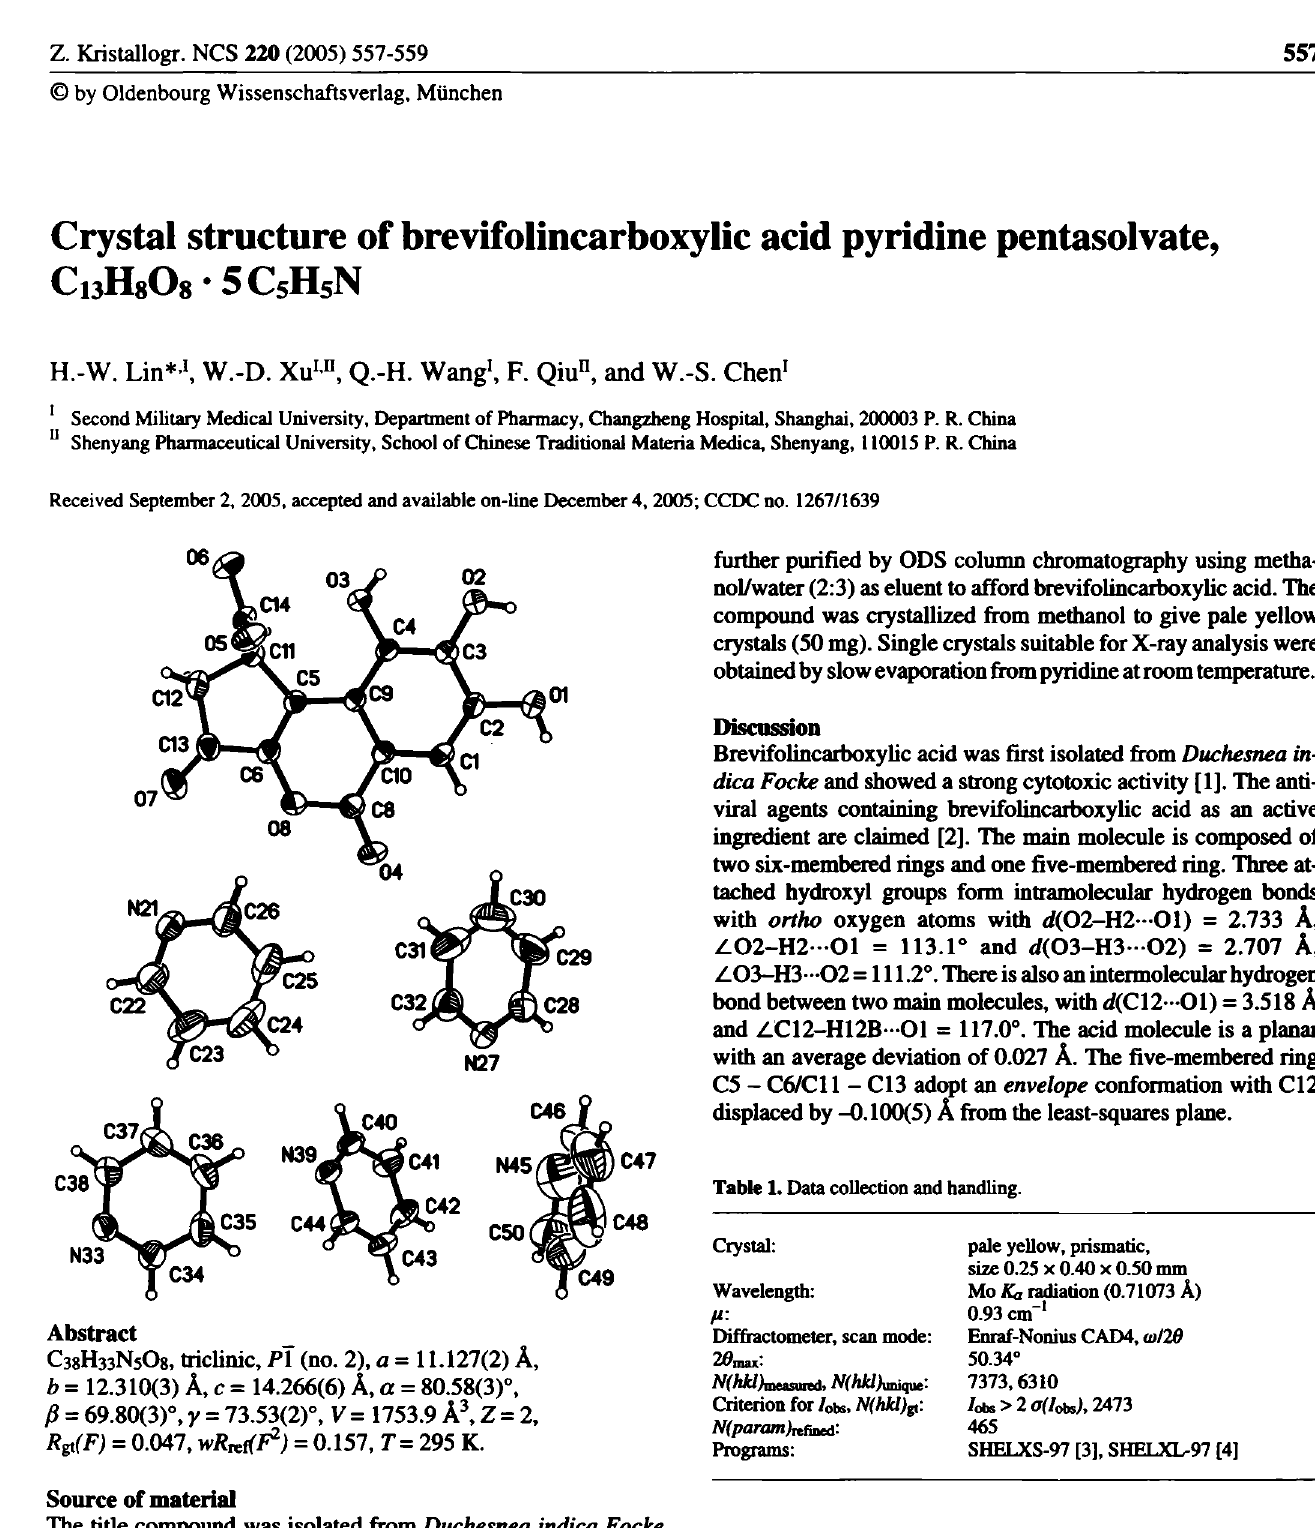
Table 2. Atomic coordinates and displacement parameters (in Ä 2